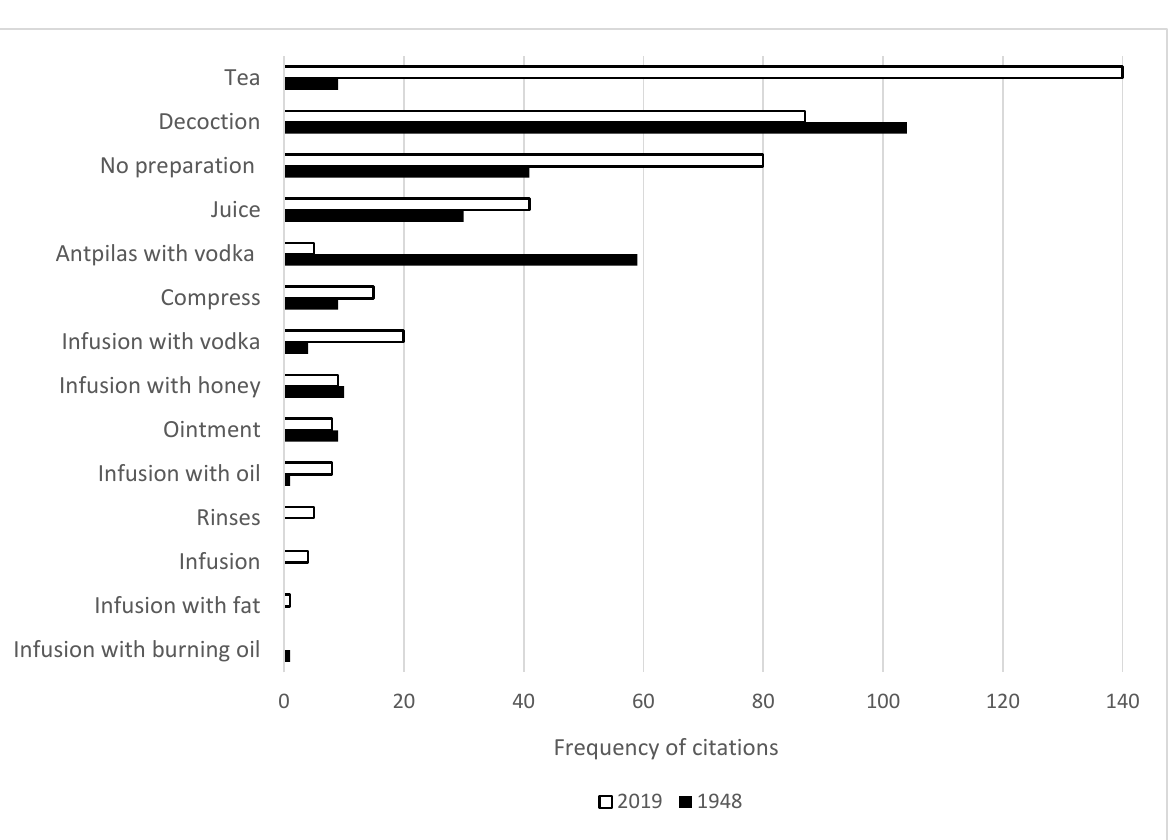
Figure 4. Preparation methods of herbal material.